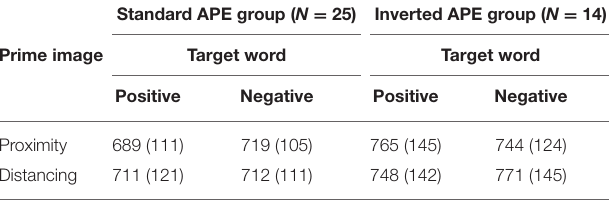
TABLE 1 | Mean response times in milliseconds (with standard deviations (SDs) in parenthesis) as a function of kind of prime (proximity and distancing) and type of target (positive and negative) for each group (standard affective priming effect (APE) and inverted APE) separately. Standard APE group ( N = 25) Inverted APE group ( N =